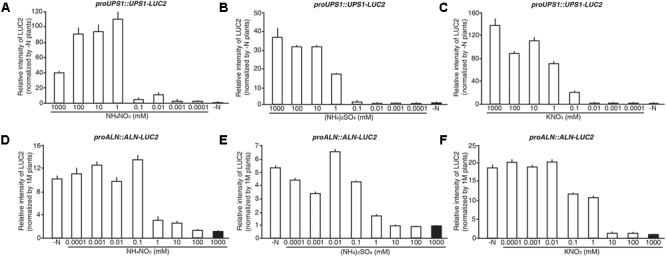
N responsive range of proUPS1::UPS1-LUC2 and proALN::ALN-LUC2 in rice plants. Relative intensity of the luminescent signals in T3 homozygous proUPS1::UPS1-LUC2
(A–C) and proALN::ALN-LUC2
(D–F) plants, which were grown on GM–N (growth media –N) for 4 days followed by the growth in 0, 0.0001, 0.001, 0.01, 0.1, 1, 10, 100, or 1,000 mM ammonium nitrate (A,D), ammonium sulfate (B,E) and potassium nitrate (C,F) for 1 day. Data shown are the mean + SD of 3 T3 homozygous lines for each N sensor (n = 9 for each line).